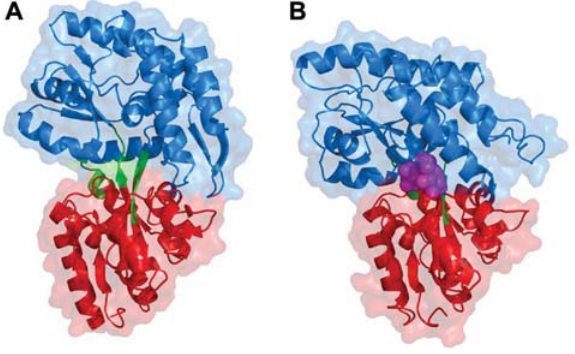
Figure 1 Crystallographic models of maltose-binding protein (MBP), a representative PBP. The N-domain is colored red, the C- domain blue, and the linker segments green; backbone traces are shown along with the translucent surface representation of all heavy atoms. The open-unliganded conformation (PDB ID 1OMP) is dis- played in (A), and the closed, maltotriose-loaded (PDB ID 3MBP) in (B). Maltotriose atoms are displayed as magenta spheres. N- domain backbone atoms were used to align both structures prior to their lateral translation into (A) and (B). All graphical representa- tions of atomic coordinates were generated with PyMOL (http:// pymol.org).